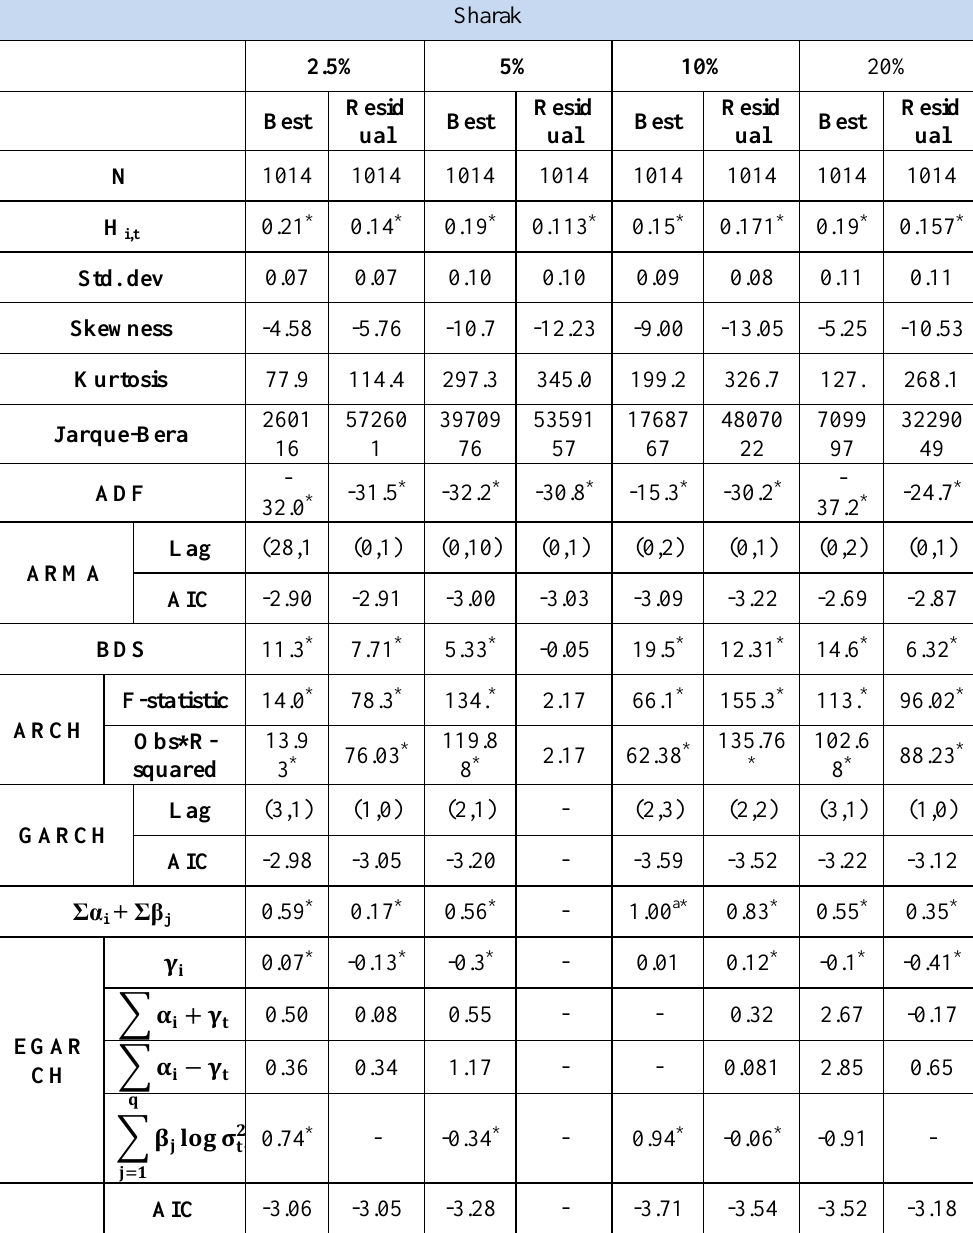
Table 4. Econometric statistics for Sharak price series estimated by